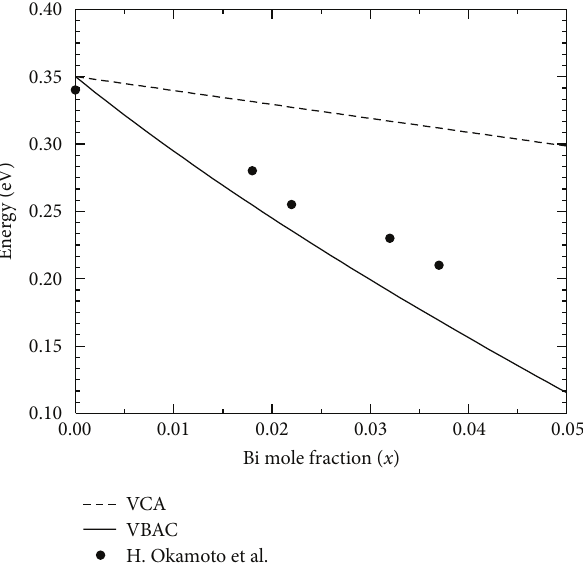
Figure 3: Theoretically calculated band gap of InAsBi as a function of Bi mole fraction using VCA and VBAC model. Experimental values of band gap are taken from [3].